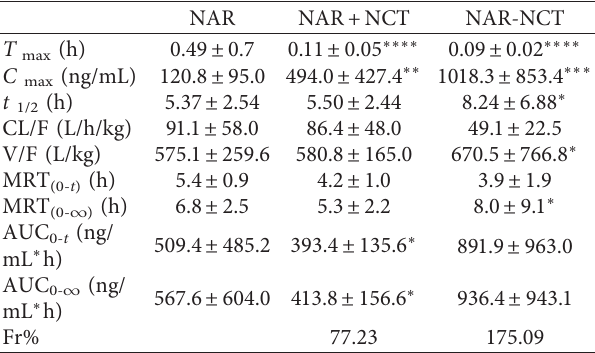
Table 4: Noncompartmental pharmacokinetic parameters of NAR after oral administration.